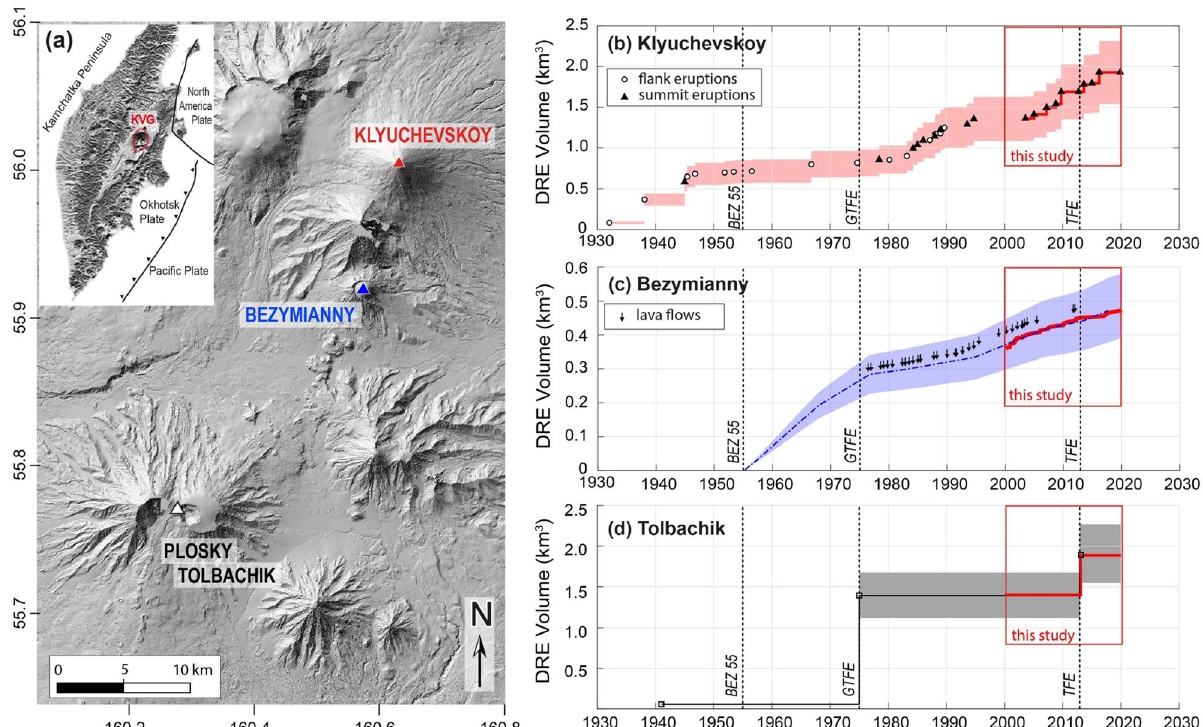
Figure 1.. ( a ) Distribution of volcanic centers within the Klyuchevskoy Volcanic Group (KVG). Right panels show the Cumulative Dense Rock Equivalent (DRE) volumes of lavas erupted between 1930 and 2020 for ( b ) Klyuchevskoy 21 , ( c ) Bezymianny 27 , and ( d ) Tolbachik 28 . All volumes are recalculated for DRE using: (i) a magma density of 2800 kg m −3 and an average density of lava flows of 2500 kg m −3 for Klyuchevskoy and Tolbachik 28 ; (ii) a magma density of 2500 kg m −3 and an average density of lava dome of 2000 kg m −3 for Bezymianny 29 . A standard error of ± 20% (colored fields) takes into account uncertainties in the estimates of bulk volumes and densities of erupted products. Red bold lines within insets, correspond to satellite-derived volumes (this work; see “Methods”). The grey bars outline the timing of the Bezymianny eruption in 1955–56 (BEZ55), the Great Tolbachik Fissure Eruption in 1975 (GTFE) and the Tolbachik Fissure Eruption in 2012 (TFE). Shaded relief map derived from ArcticDEM digital elevation model (https:// www. pgc. umn. edu/ data/ arcti cdem/) and elaborated using QGIS version 3.16.3 (http:// qgis. osgeo. org); Time series generated using MATLAB software (www. mathw orks.